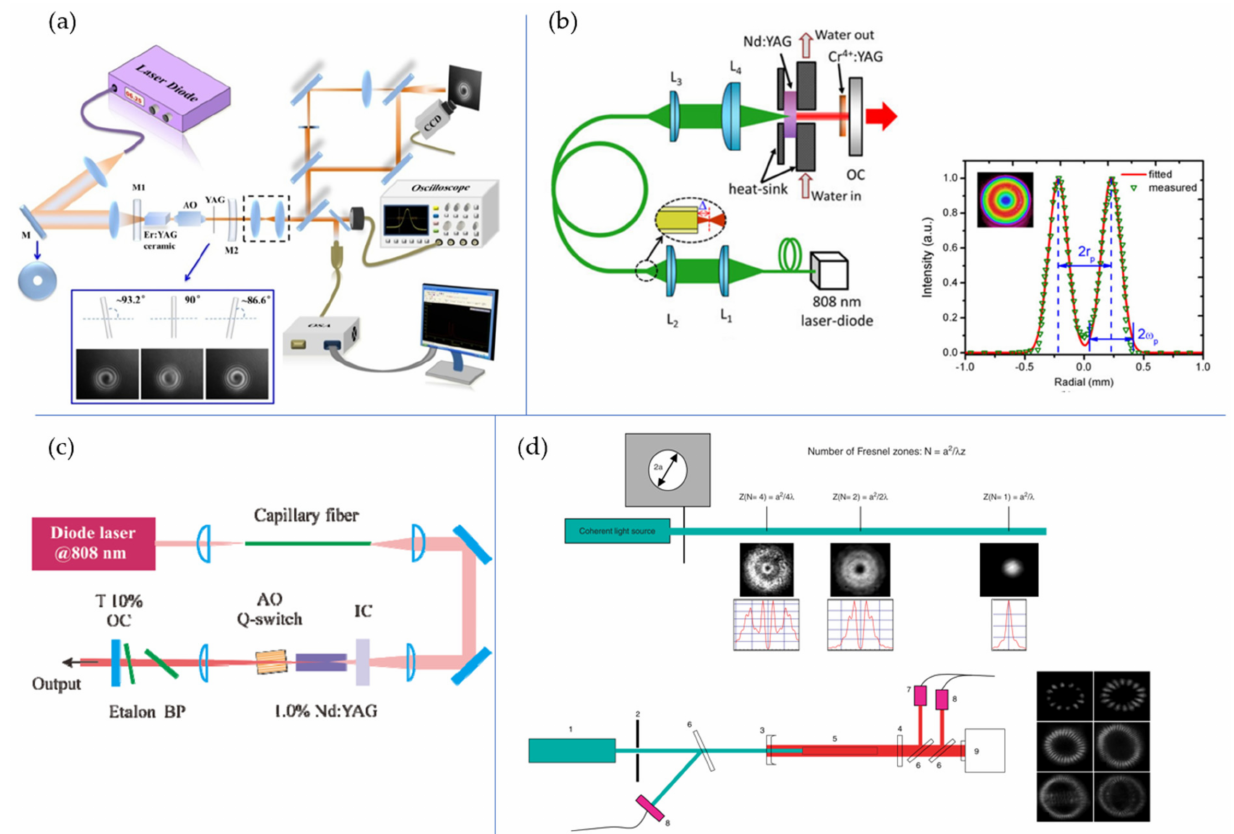
Figure 1. Annular-pumped vortex lasers. The annular pump beam is produced through ( a ) hollow mirror (Reprinted with permission from [88] © The Optical Society), ( b ) multi-mode fiber combined with defocusing characteristic (Reprinted with permission from [92] © 2015 Elsevier B.V), ( c ) capillary fiber (Reprinted with permission from [96] © The Optical Society), and; ( d ) diffractive optical device (Reprinted with permission from [99] © 2005 by Astro